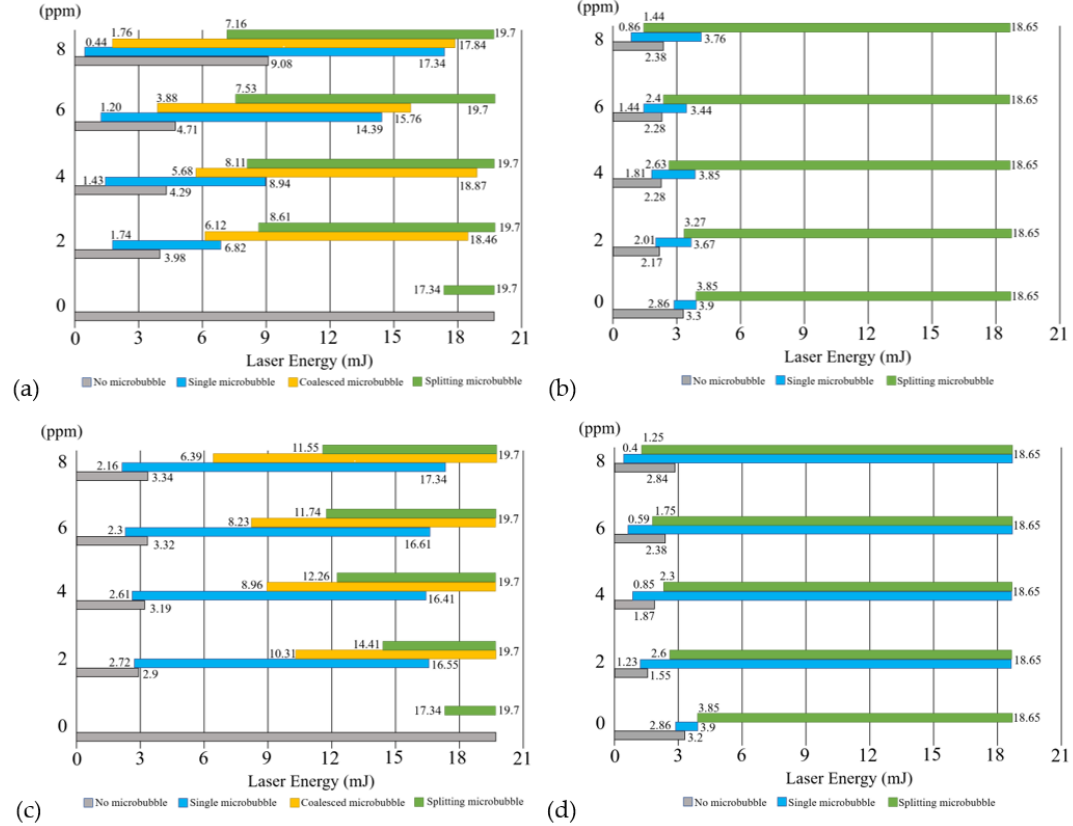
Figure 8. Ranges of pulsed energy to generate different types of microbubbles (single bubble, coa- lesced bubble, splitting bubble) in two kinds of GNR colloids with different concentrations (0, 2, 4, 6, 8 ppm). Microbubbles induced in a GNR colloid with SPR of 966 nm by pulsed lasers of ( a ) λ = 980 nm (on resonance) and ( b ) λ = 700 nm (off resonance). Microbubbles induced in a GNR colloid with SPR of 718 nm by pulsed lasers of ( c ) λ = 980 nm (off resonance) and ( d ) λ = 700 nm (on reso- nance). Several previous studies using high-speed cameras have proven that the laser-in- duced plasma in water usually exhibits a line shape, indicating series-connected multiple